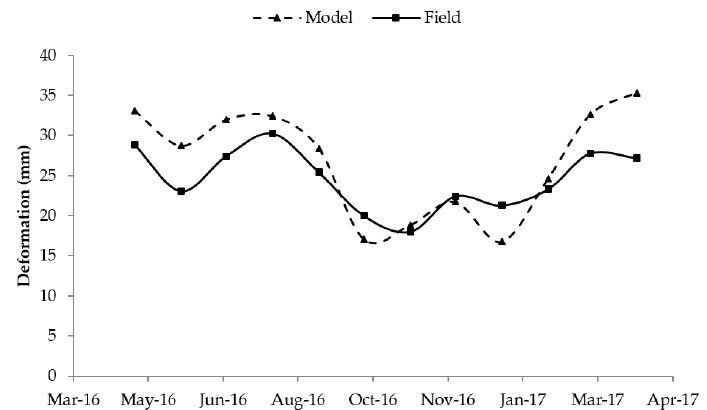
Figure 17. Comparison of model and field results on modified model.